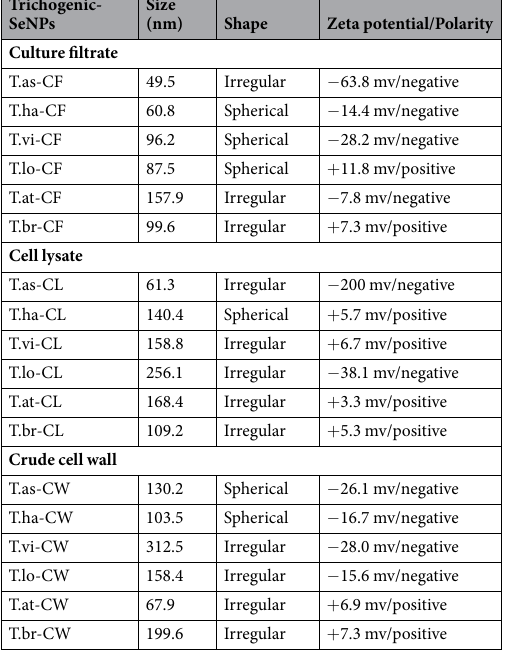
Table 1. Summary of Trichogenic-selenium nanoparticles (SeNPs) characters. T.as – T . asperellum ; T.ha – T . harzianum ; T.vi – T . virens ; T.lo – T . longibrachiatum ; T.at – T . atroviride ; T.br – T . brevicompactum ; CF – Culture filtrate, CL – cell lysate; CW – crude cell